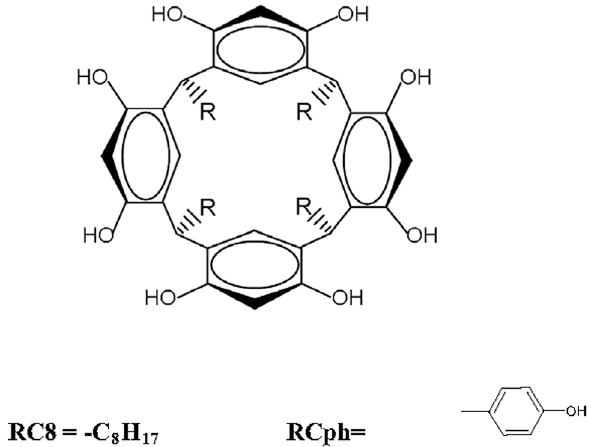
Fig. 1 Chemical structure of calix[4]resorcinarenes